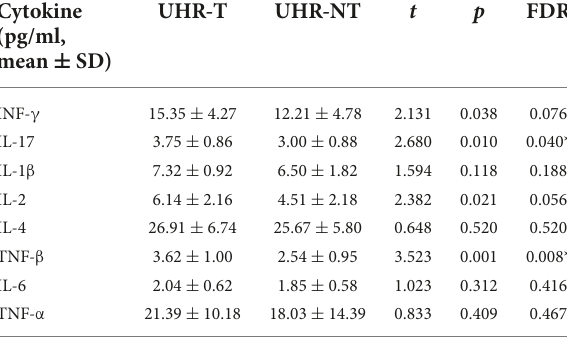
TABLE 3 IL-17 and TNF- β levels were higher in the UHR-T group than in the UHR-NT